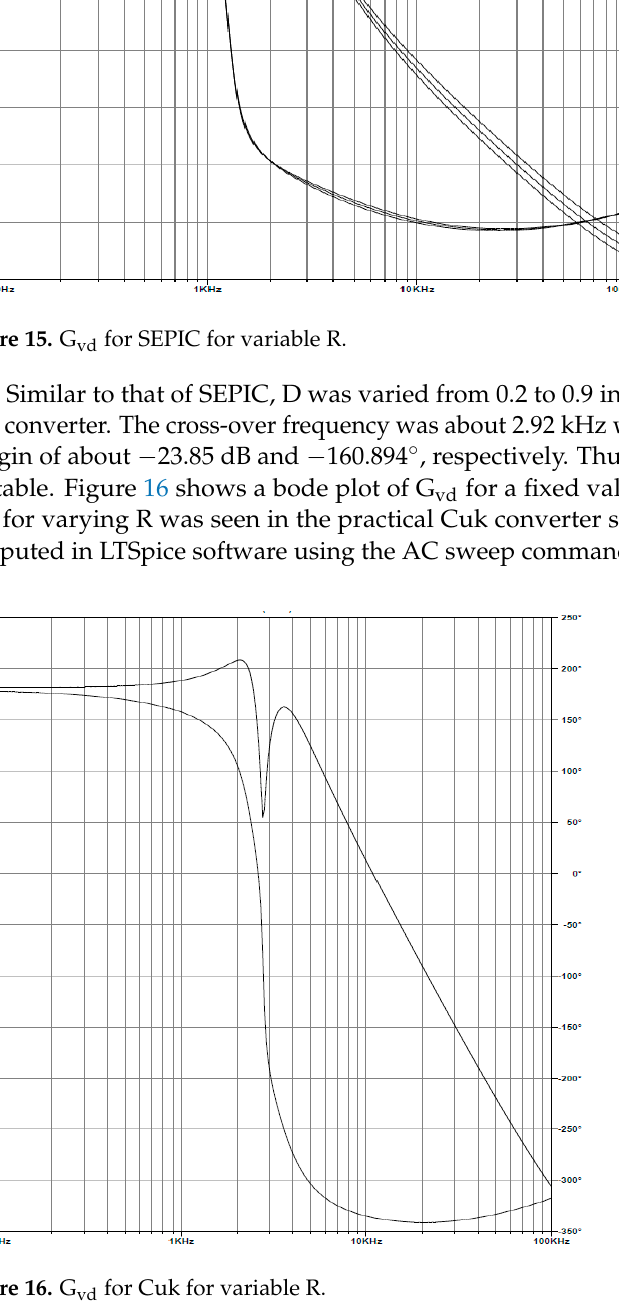
Figure 17. G vd for Cuk for variable R.